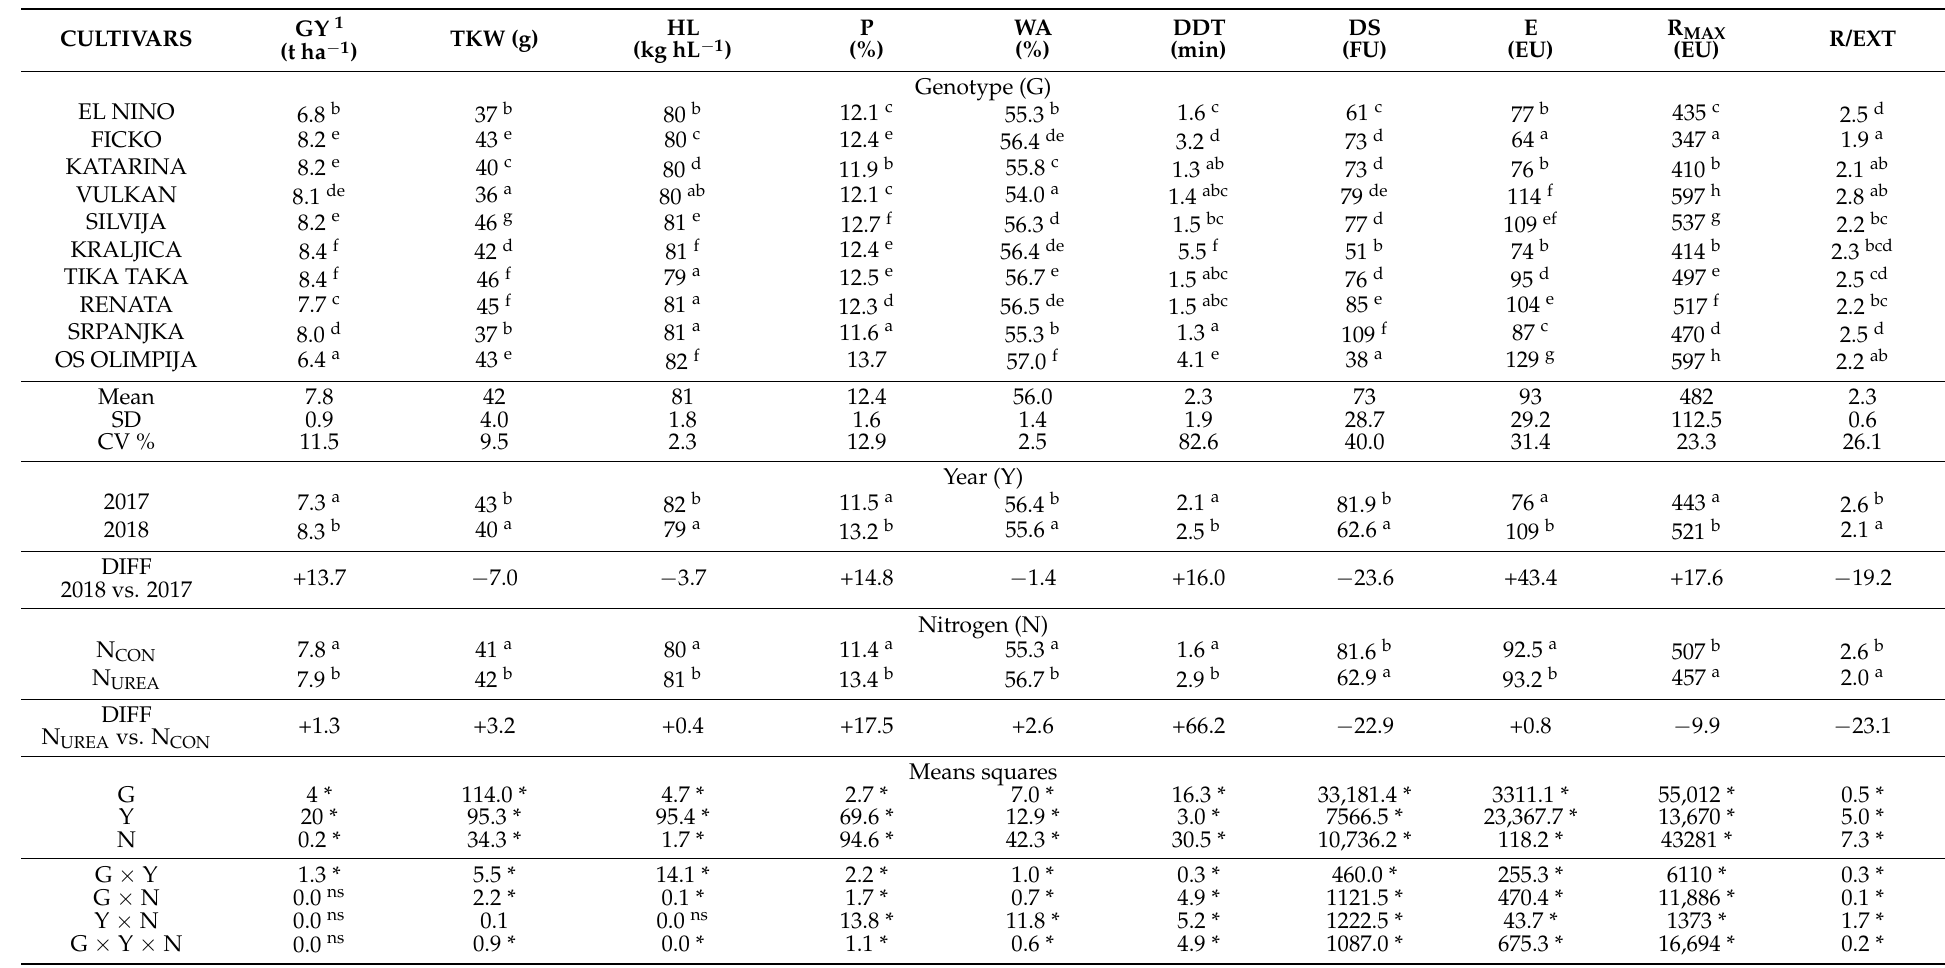
Table 4. The mean values and the effects of the late-season urea application on yield and bread-making quality of wheat cultivars.